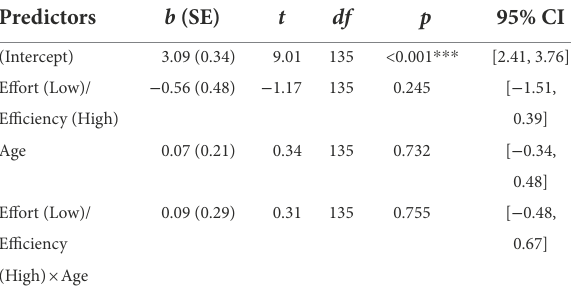
TABLE 3 Fixed effects from the linear mixed-effects model predicting credibility ratings as a function of informant effort/efficiency and child